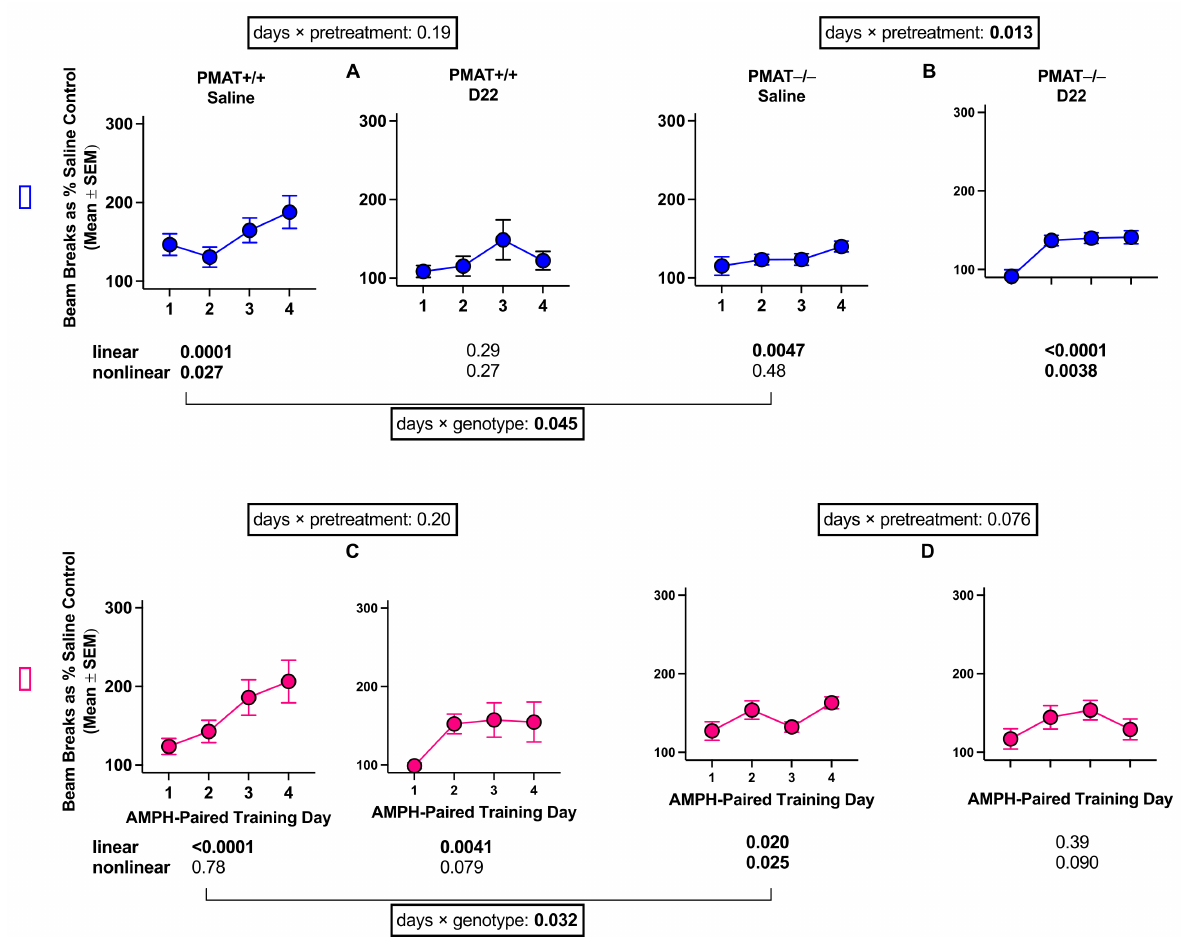
Figure 4. Sensitization to the locomotor stimulating effects of amphetamine (AMPH) in male ( A,B ) and female ( C,D ) PMAT+/+ and PMAT − / − mice treated with saline or decynium 22 (D22) before amphetamine. Each part of the figure ( A–D ) shows the p value for the days by pretreatment interaction for each genotype and each sex. In addition, a p value is shown for the comparison of genotypes in saline-pretreated males and females. Additionally, each of the 8 panels (n = 16 mice per panel) shows p values for linear and nonlinear trends across days. Statistically significant p values are shown in